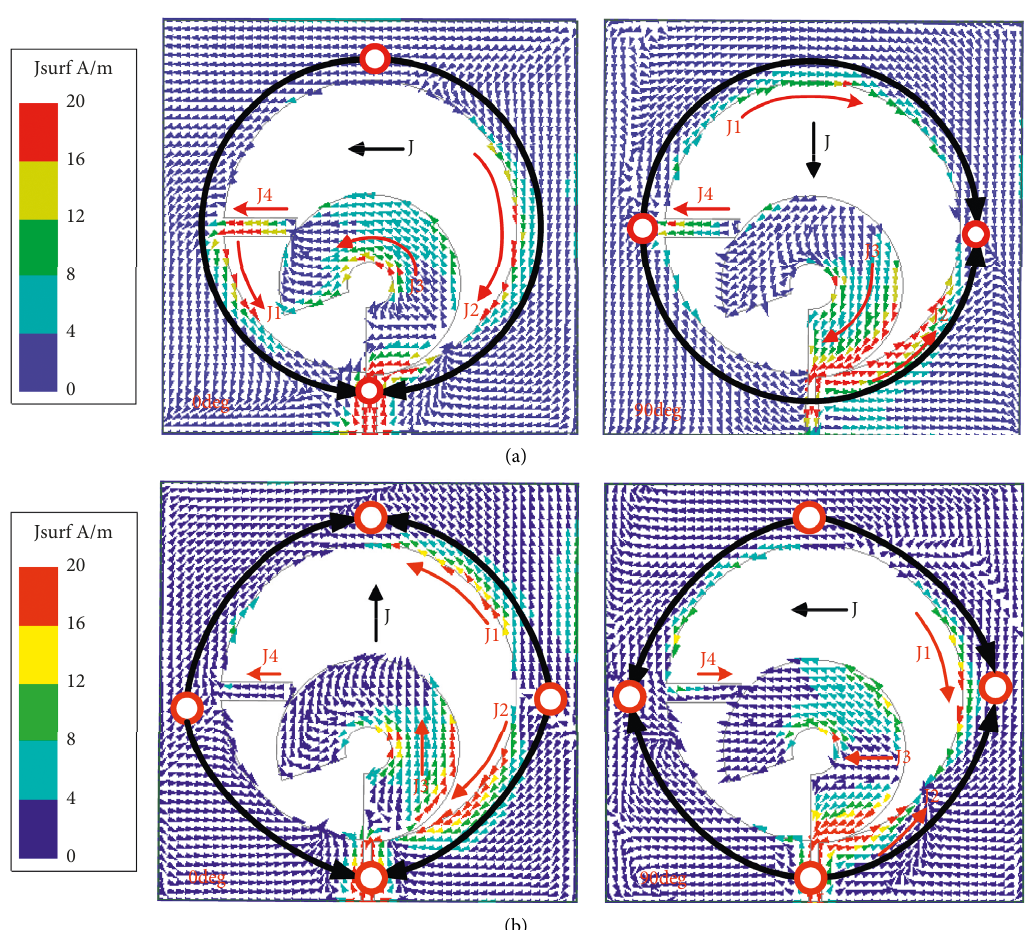
Figure 4: Simulated surface current distributions of the proposed antenna at (a) 3.45GHz and (b) 5.1 GHz.